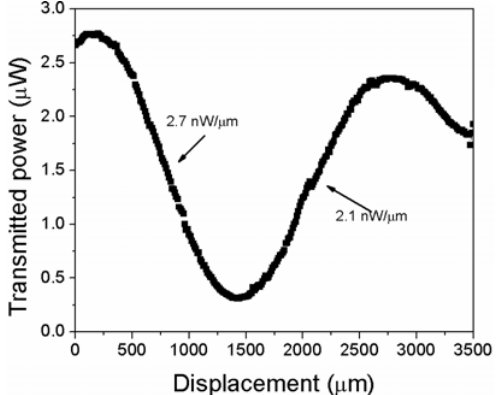
Figure 8. Measured transmitted power as a function of displacement by using a 1,280 nm, 100 nm bandwidth LED source and a Ge photodetector.